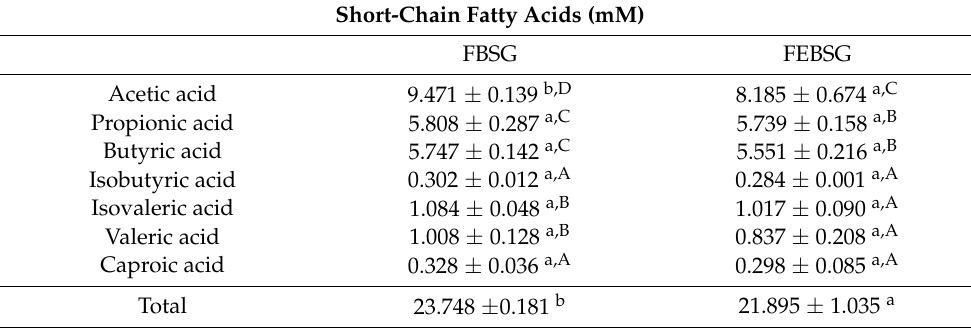
Table 6. Short-chain fatty acids and organic acids present in FBSG and